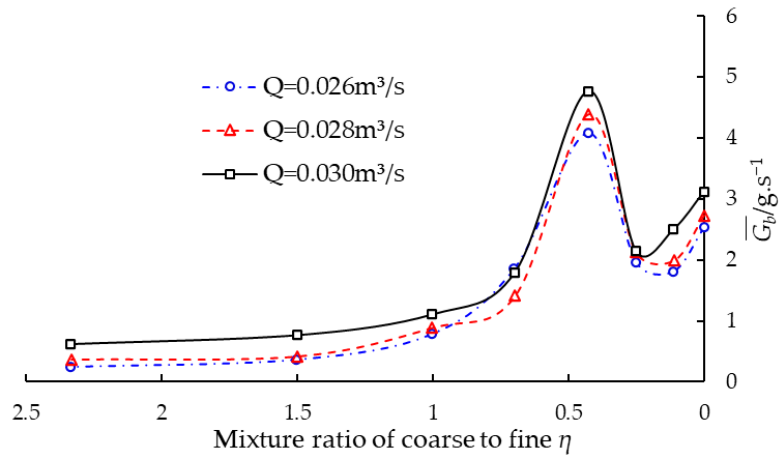
Figure 12. Relationship curves between the average transport rates G b and mixture ratio η under different flow conditions. The curves of the average bed load transport rates with the mixture ratio